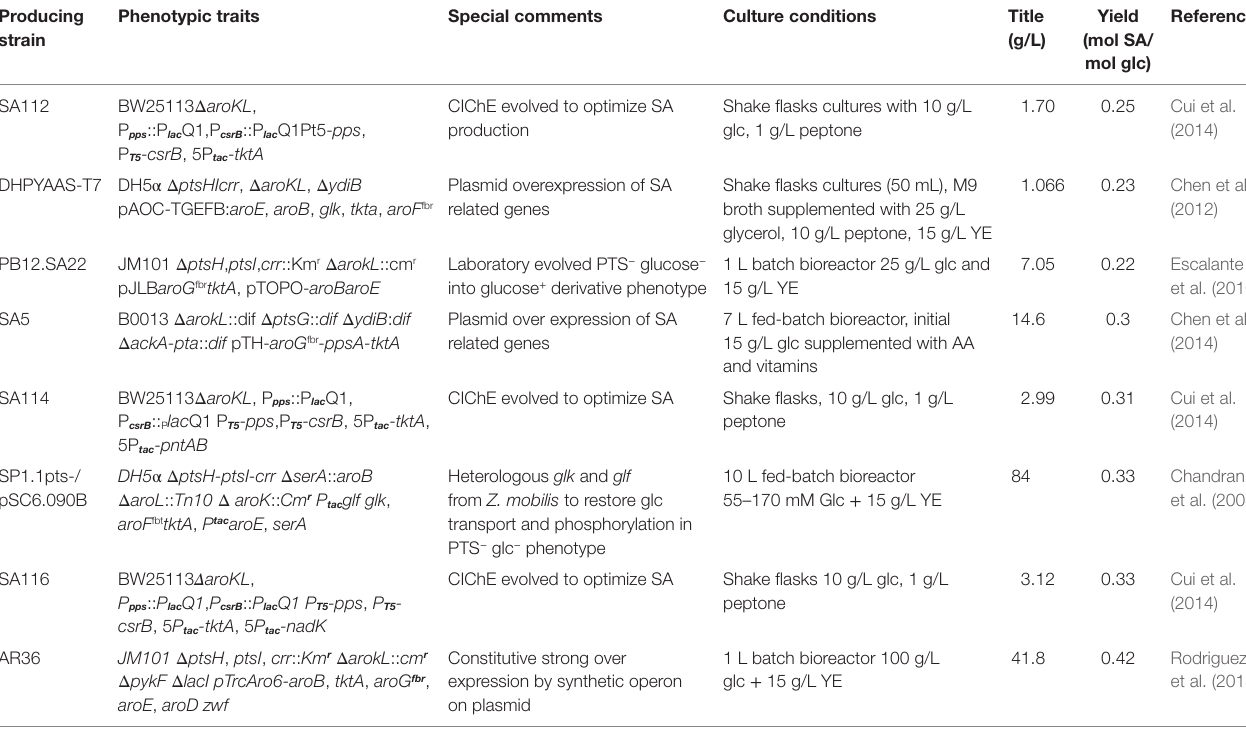
TABLe 1 | Relevant E. coli engineered strains for SA production. Producing